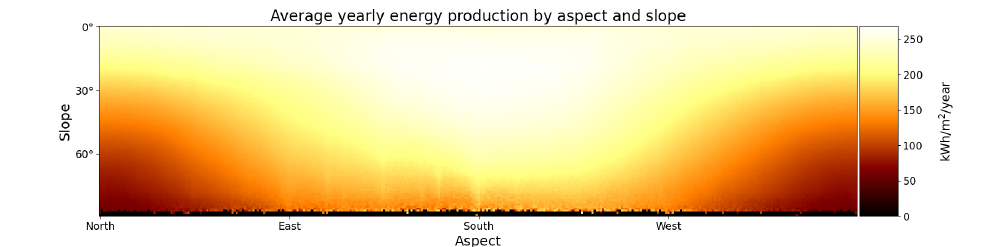
Figure 11. Average annual energy production per m 2 based on the orientation and inclination of photovoltaic panels in Sardinia.